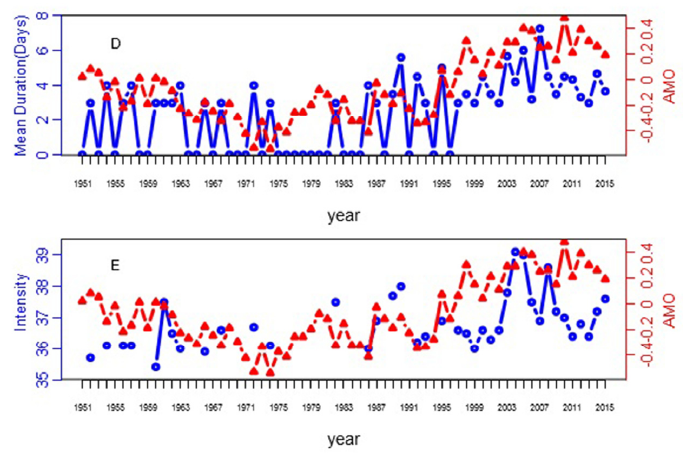
Figure 5. The time series of annual Atlantic Multi-decadal Oscillation (AMO) and annual frequency ( A ), total duration ( B ), maximum duration ( C ), mean duration ( D ) and intensity ( E ) of heat waves. For the total of 14 cold spells observed during 1951–2015, the mean duration was 8.18 days and the longest duration was 17 days in January 1969. The coldest day of cold spells occurred on 29 December 1991 with a minimum temperature of 0.90 °C. The variation trend of frequency, duration and intensity of cold spells is shown in Figures 6 and 7. The annual frequency, mean duration and intensity of cold spells did not show a significant linear trend at the 95% confidence level ( p = 0.15, 0.25 and 0.41, respectively). Besides, the result of ANOVA indicated that there were no significant differences in frequency, mean duration and intensity of cold spells among El Niño years and La Niña years and Neutral years ( p = 0.08, 0.21 and 0.80, respectively). We did not find a significant linear correlation between annual AMO and the frequency, mean duration and intensity of cold spells ( p = 0.36, 0.21 and 0.88, respectively). No associations were observed between IOBW and the characteristics of cold spells ( p = 0.31, 0.21 and 0.48, respectively).